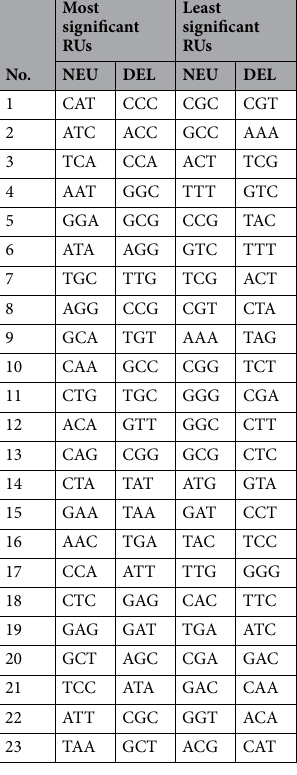
Table 5. Comparison between statistically and non-statistically significant RUs of NEU and DEL